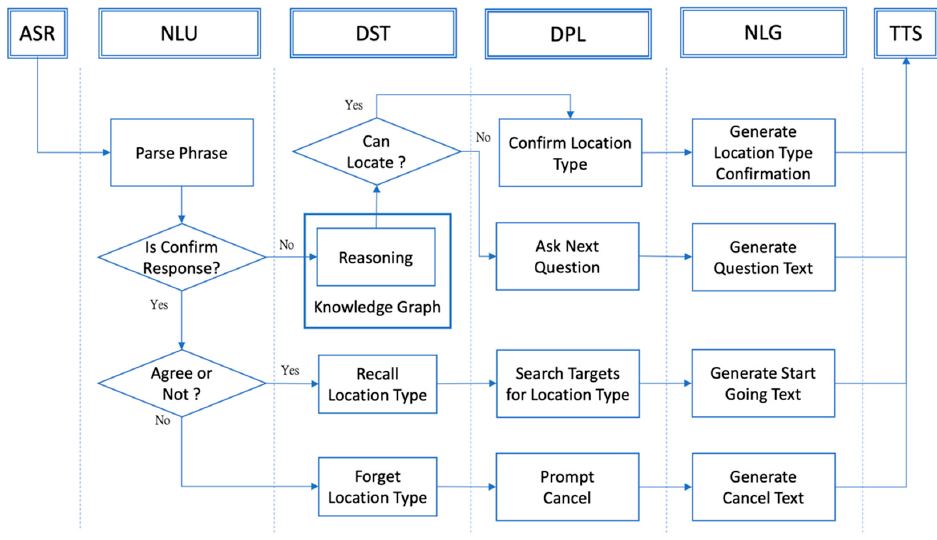
Figure 3. Implementation flowchart of dialogue system integrating knowledge graph.